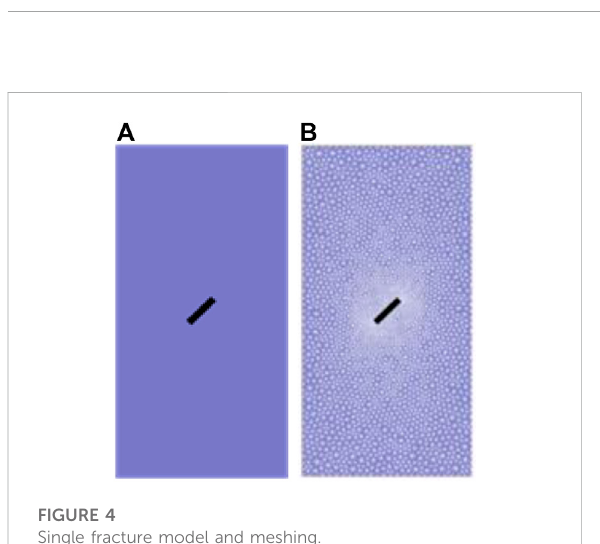
FIGURE 4 Single fracture model and meshing. FIGURE 5